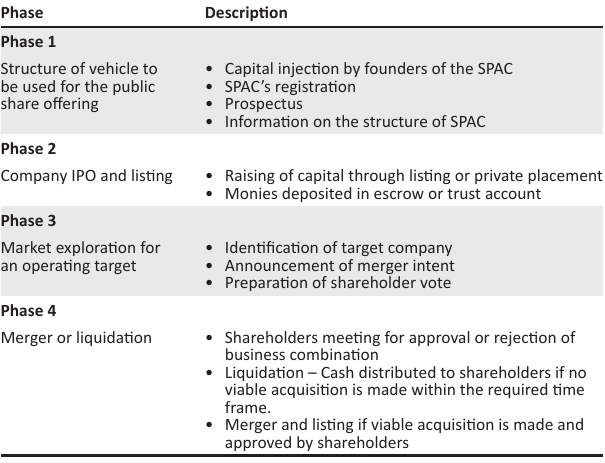
TABLE 1: The life cycle of a special purpose acquisition